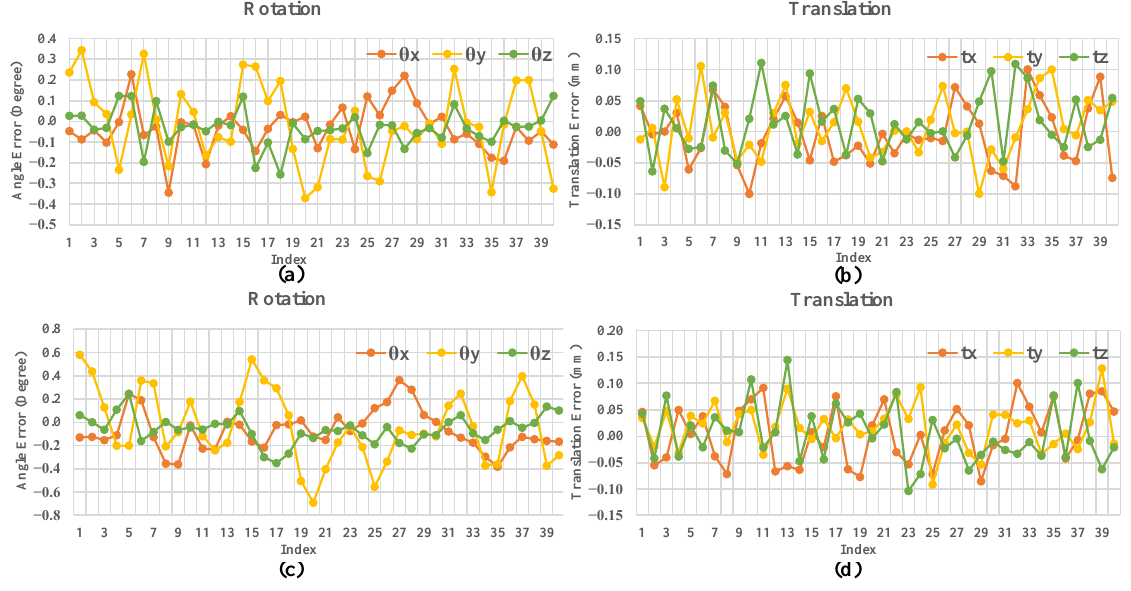
Figure 6. Pose errors between measured poses and their corresponding ground truths consisting of rotation errors (along the x, y, z-axes in degrees) and translation errors (along the x, y, z-axes in millimeters). We chose the pose measurement results of T 1 and T 3 to show the error variations. ( a , b ) are the rotation and translation errors of measurement results of T 1 , respectively. ( c , d ) are the rotation and translation errors of measurement results of T 3 .